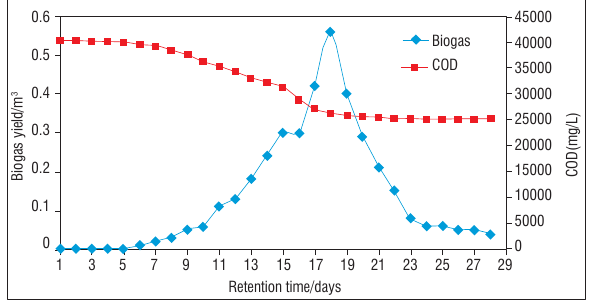
Figure 5: Relationship between gas production and COD for donkey